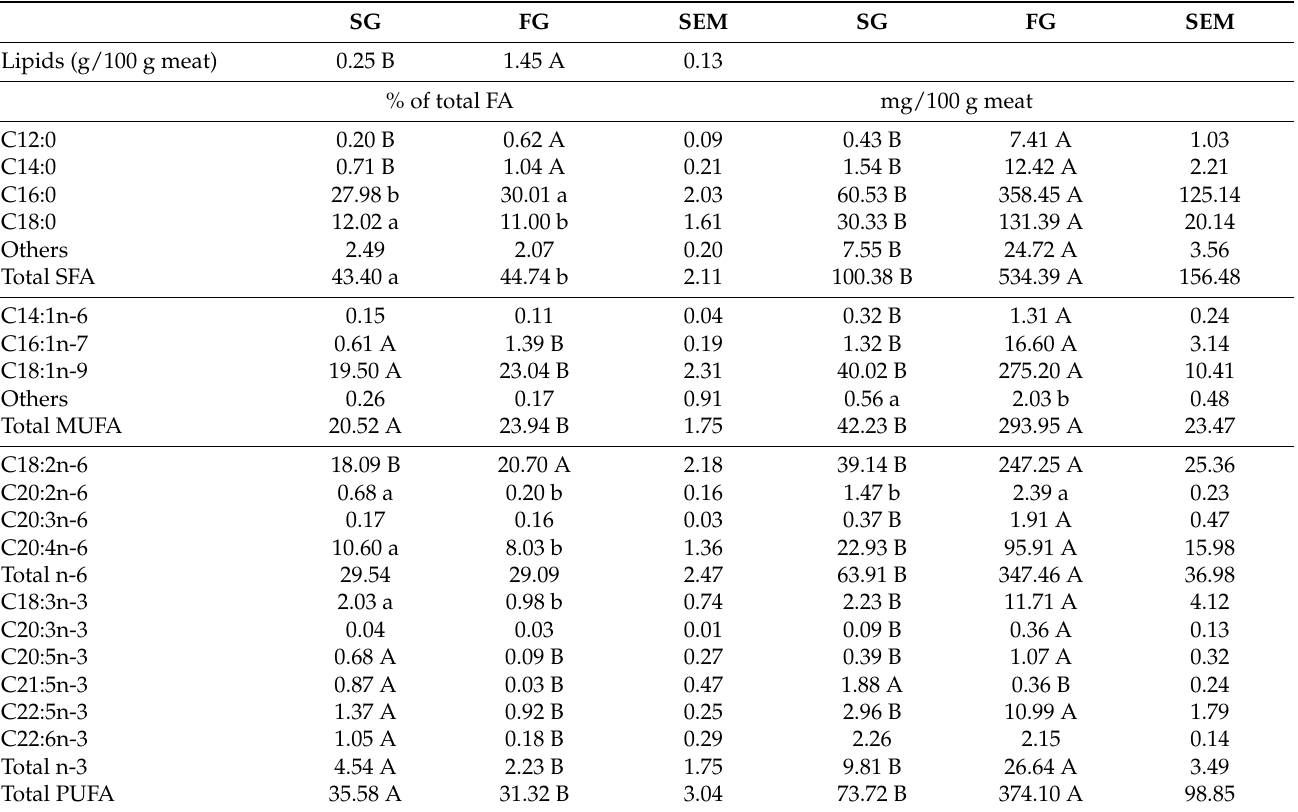
Table 3. Lipid contents (g/100 g meat) and fatty acid compositions (g/100 g fatty acids and mg/100 g meat) of breast meat from different